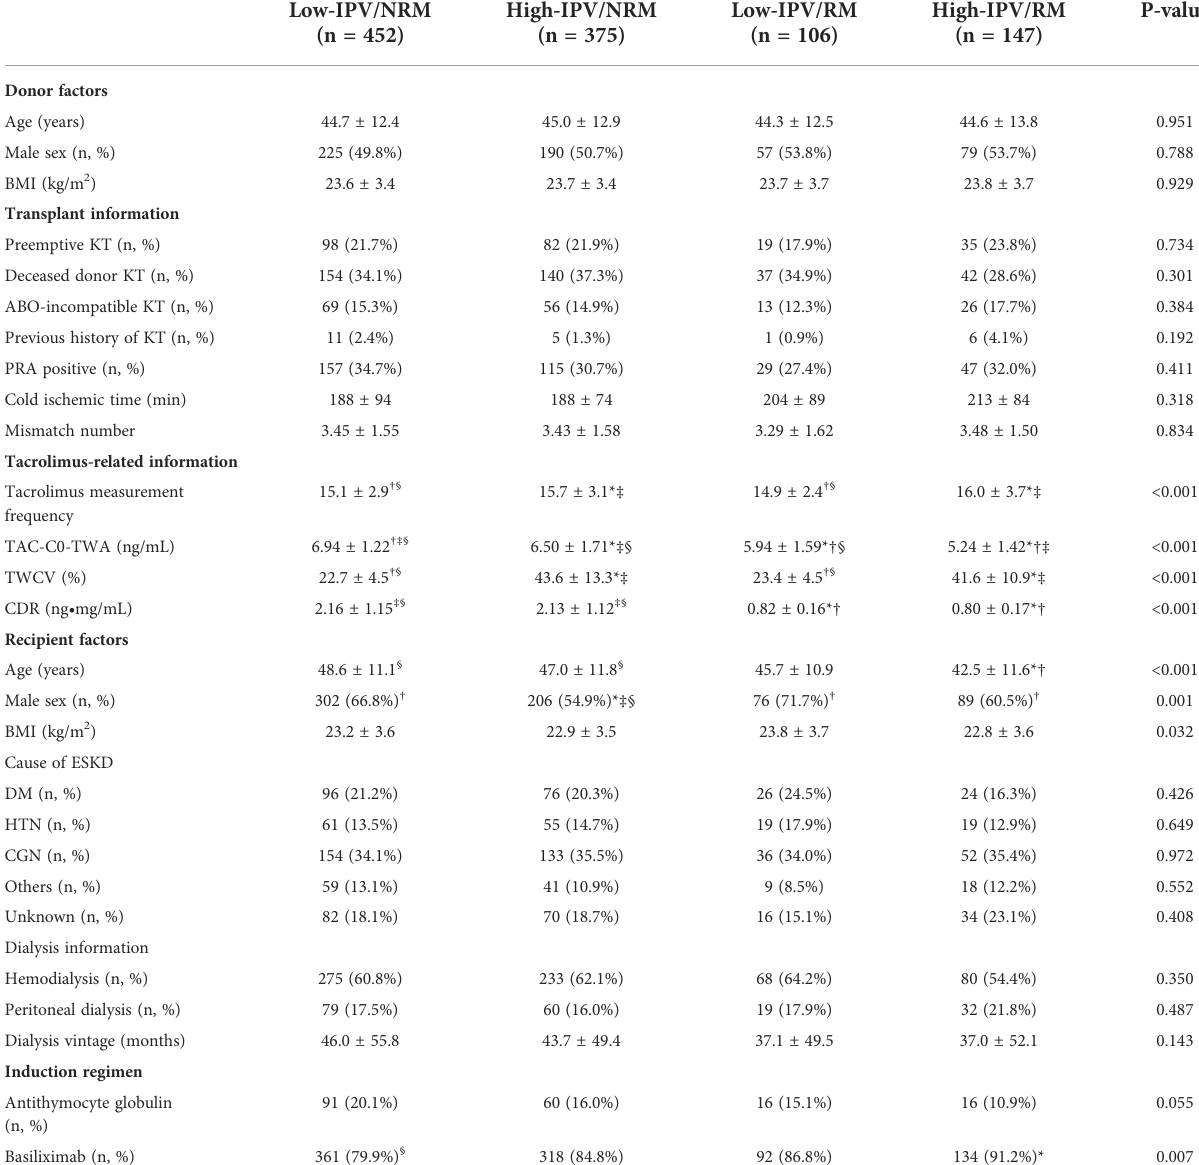
TABLE 1 Baseline characteristics according to TAC-IPV and RM/NRM